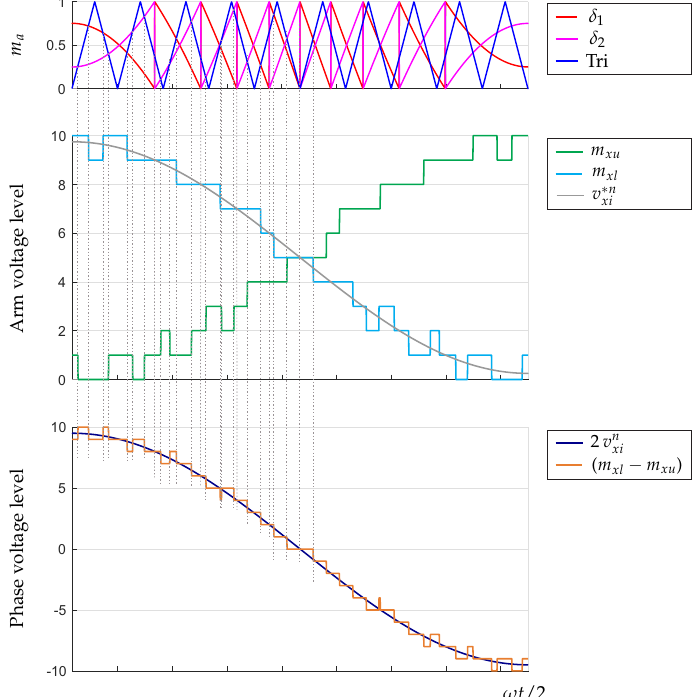
Figure 7. Operational principles of the improved SAM technique.